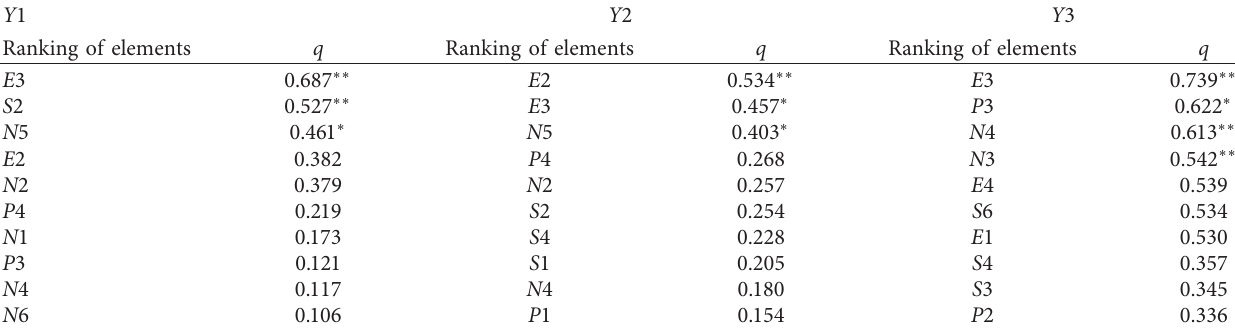
Table 8: Measurement results of dominant elements of urban resilience (top 10 by q value).